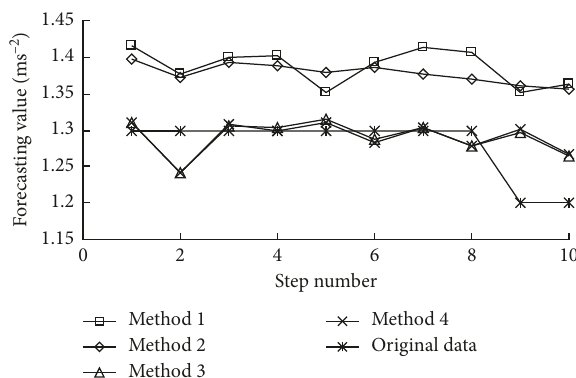
Figure 5: Chaotic prediction results for subseries X